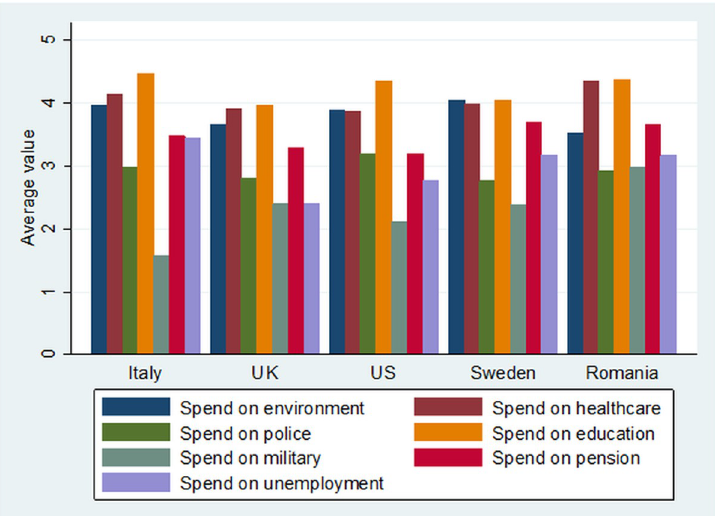
Fig 2. Country-level preferences for spending on various public policies. The five possible choices were: 5 = Spend much more; 4 = Spend more; 3 = Spend the same as now; 2 = Spend less; 1 = Spend much less. The question contained the following note: “Remember that if you check ‘much more’, it might require a tax increase to pay for it.”